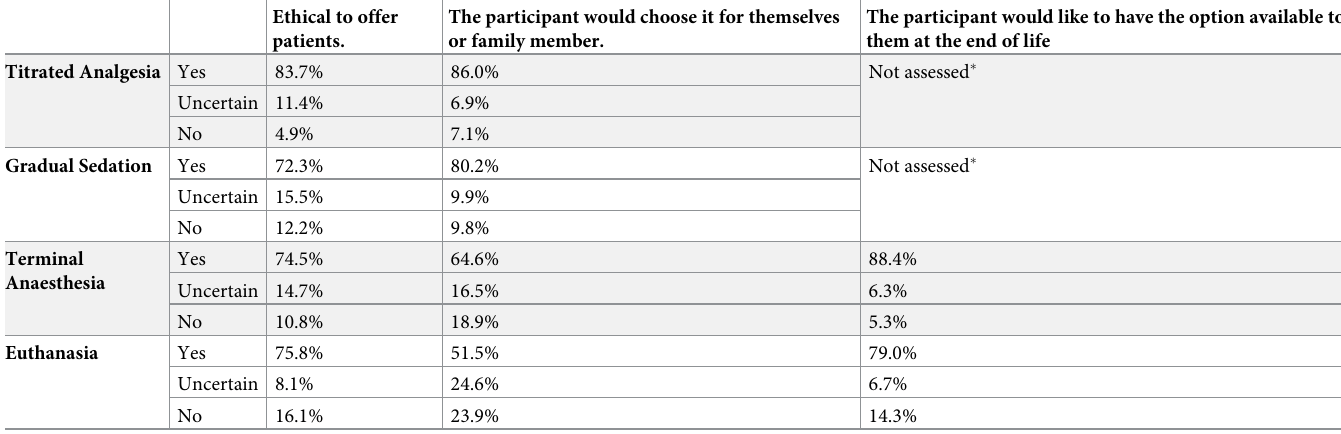
Table 2. Acceptance rates of different end of life care options (n = 509).